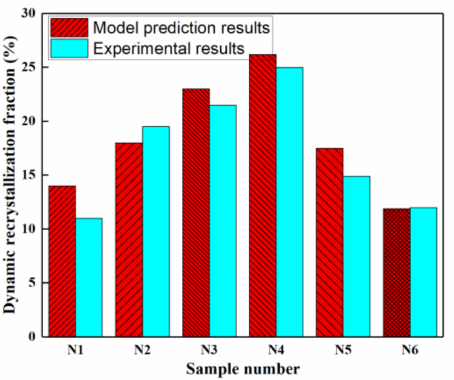
Figure 7. Comparison between experiment results and model prediction results: (N1) T = 300 ◦ C, . ε = 0.01, ε = 0.6; (N2) T = 400 ◦ C, . ε = 0.01, ε = 0.8; (N5) T = 300 ◦ C,